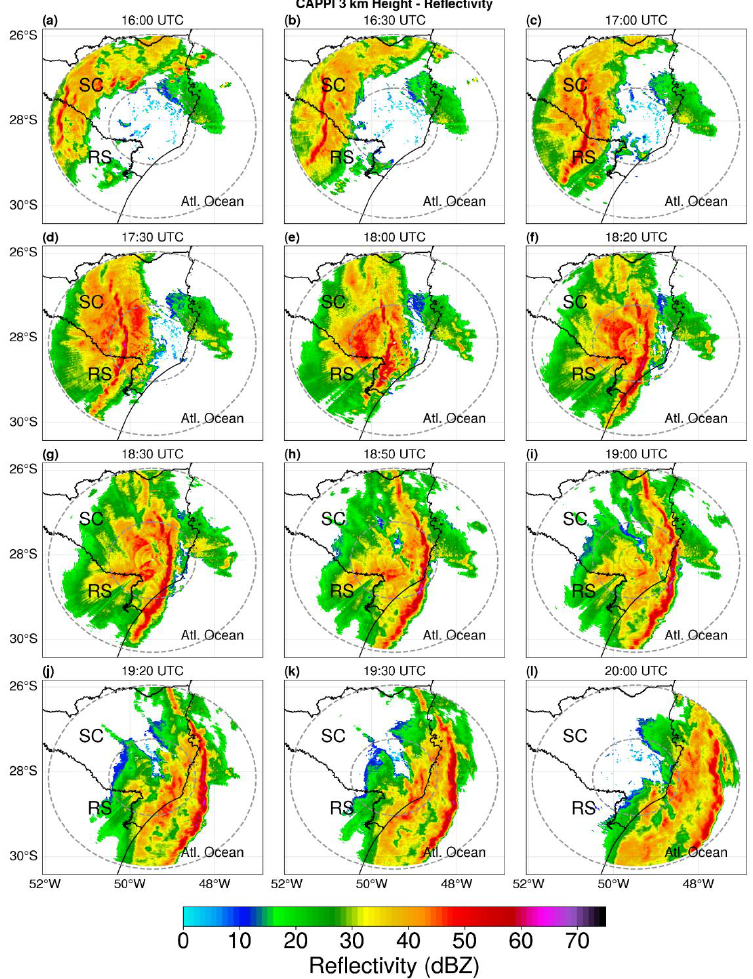
Figure 12. ( a – l ) Constant Altitude Plan Position Indicator (CAPPI) at 3 km height of reflectivity from Morro da Igreja radar from 1600 to 2000 UTC on 30 June 2020.